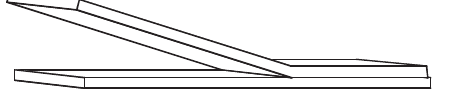
FIG. 1. Two pieces of tape are stuck together